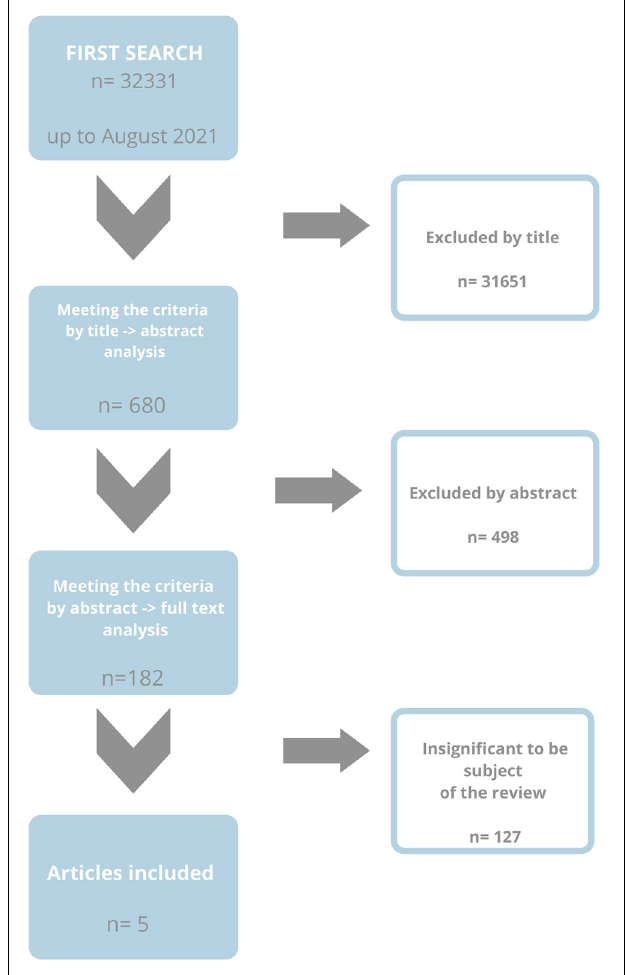
FIGURE 1 | Flow chart of research